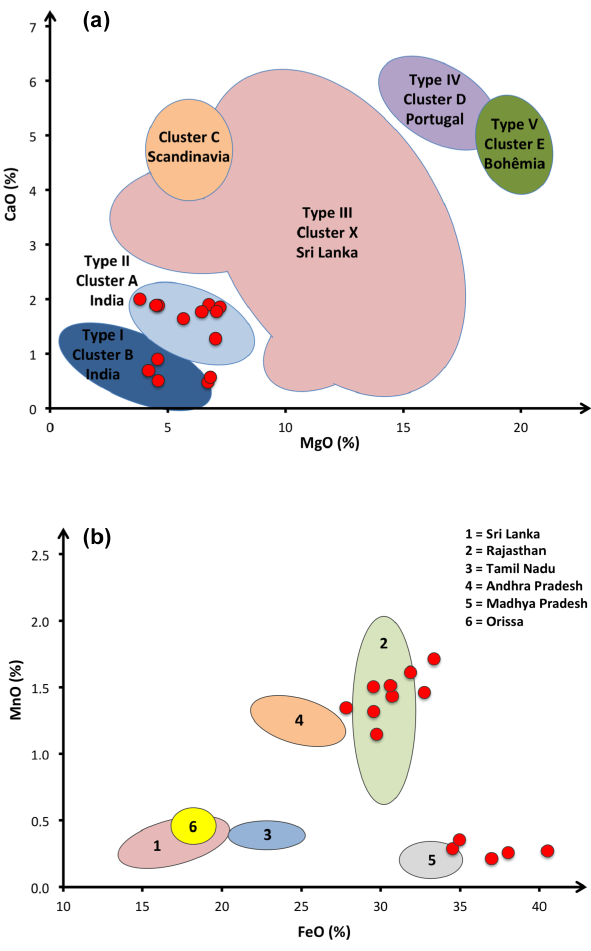
Figure 5. Compositional variations of garnet from several locali- ties. The red dots represent the samples from the reliquary crown of Namur plotted in the CaO vs. MgO diagram published by Calligaro et al. (2007) and Gilg et al. (2010) (a) , as well as in the MnO vs. FeO diagram established by Greiff (1999) (b) .